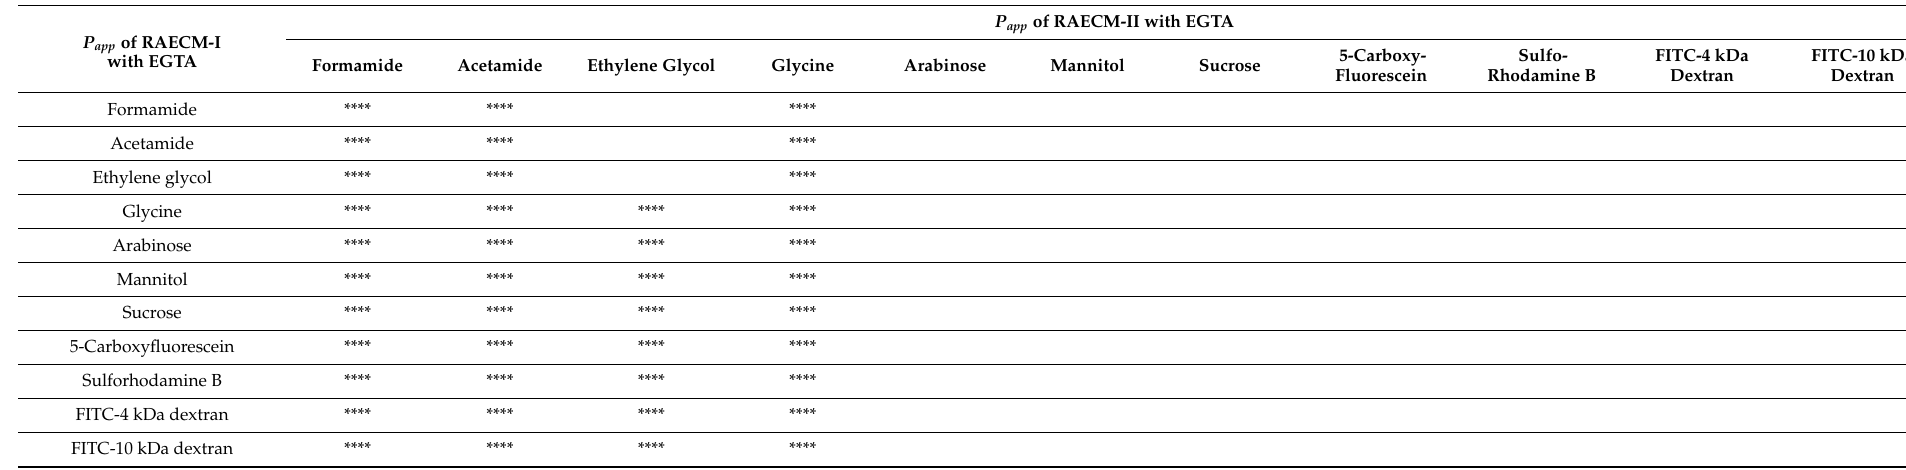
( f ) Comparison table for P app of RAECM-I with EGTA vs RAECM-II with